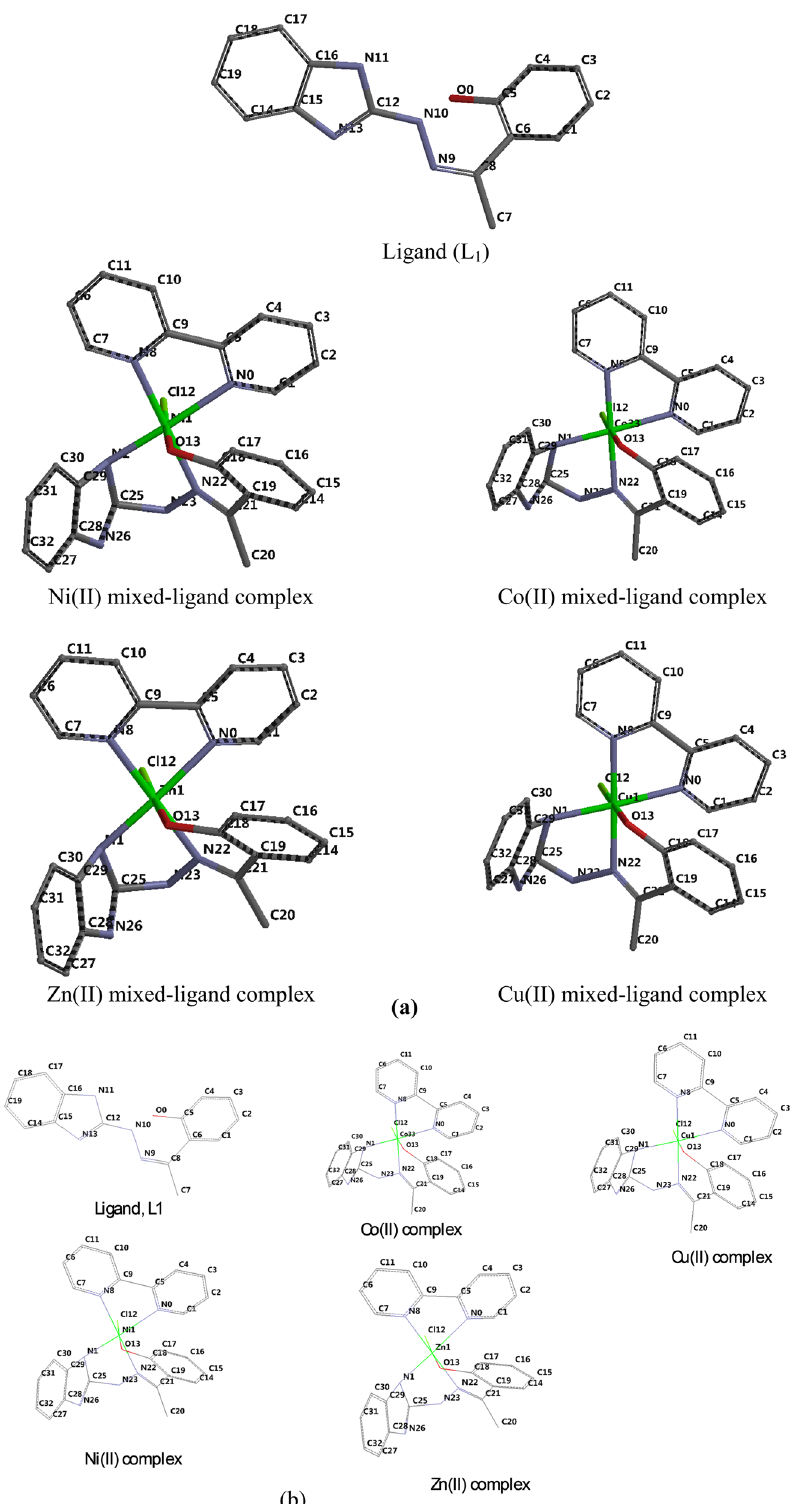
Figure 1: ( a ) Tube representation and ( b ) wire representation of the optimized molecular structure of ligand and mixed - ligand metal complexes ( numbering of the atoms was done according to the software )